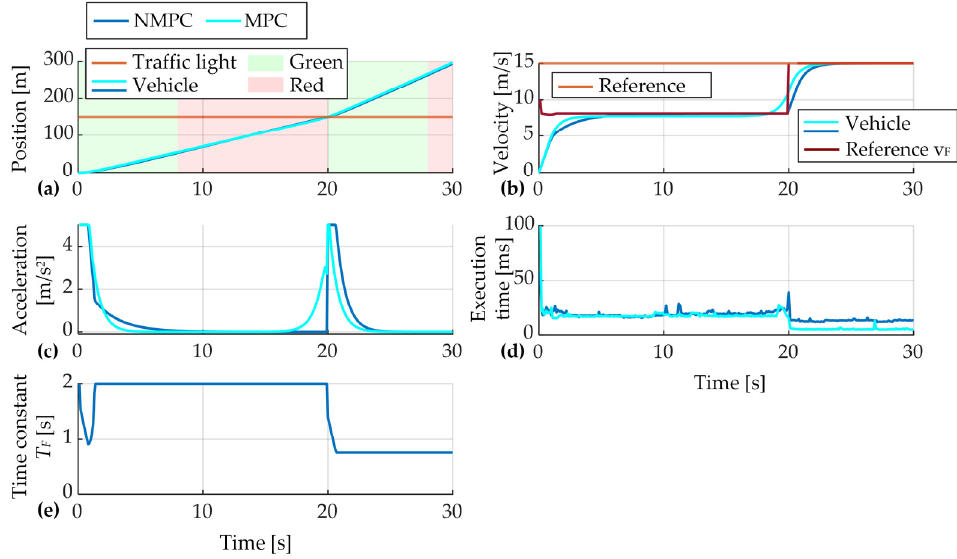
Figure 13. Comparative responses of position ( a ), velocity ( b ), acceleration ( c ), execution time ( d ) and time constant input ( e ) of MPC and NMPC systems.